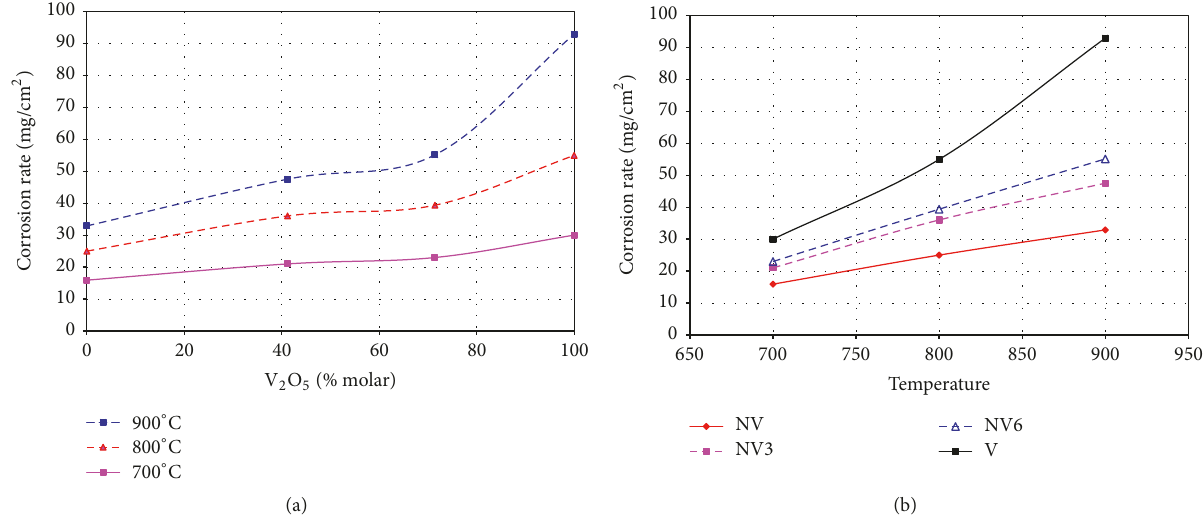
Figure 10: (a) Effect of the NV: V ratio and (b) temperature on Ni corrosion rate after 100